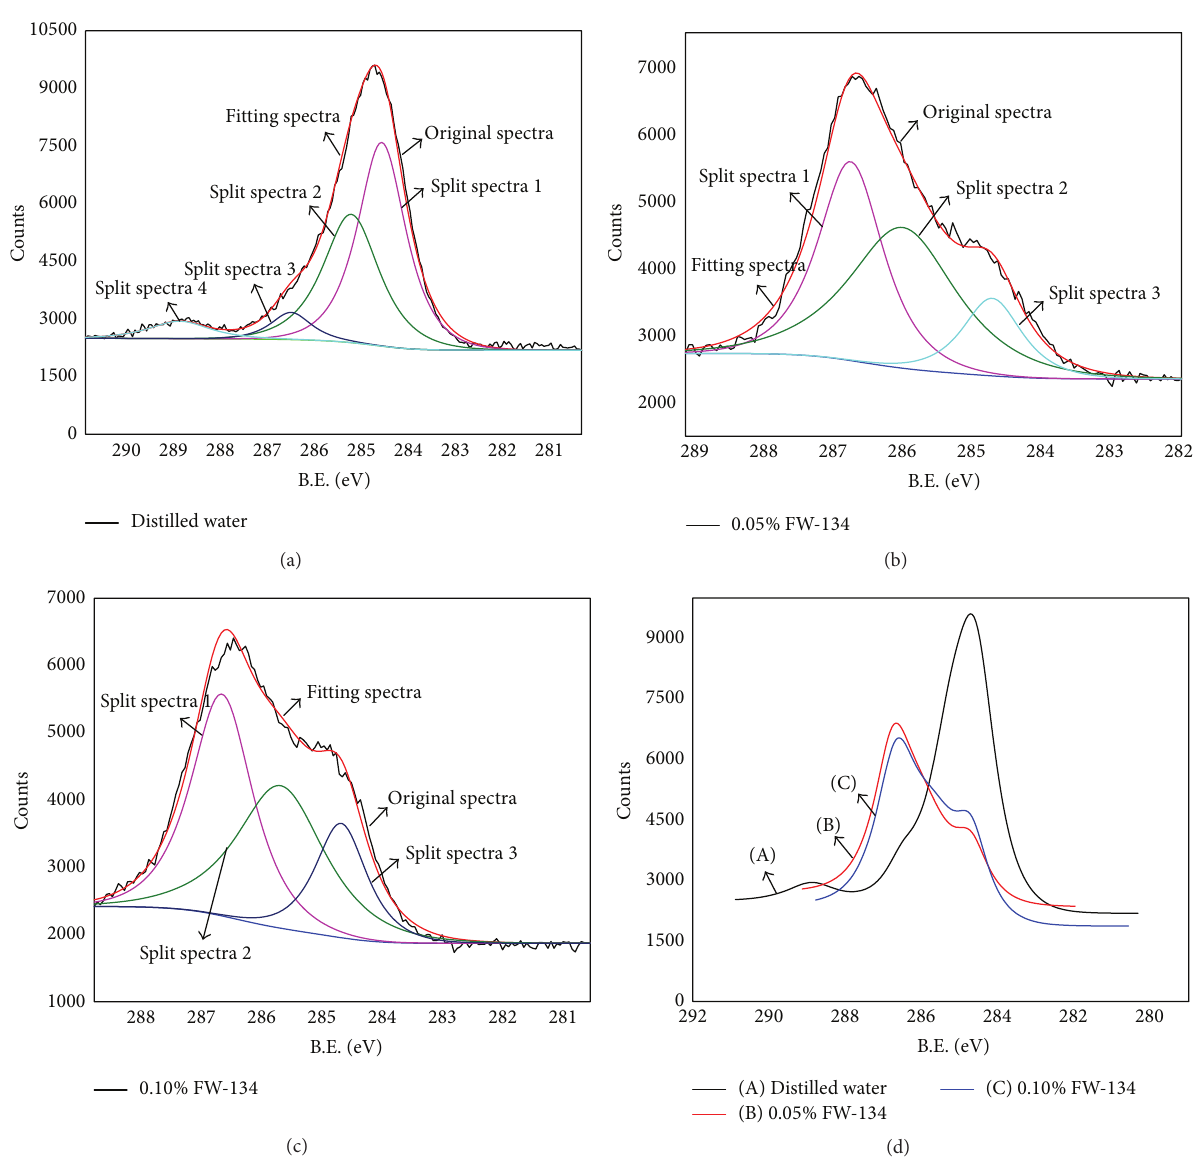
Figure 5: XPS C1s spectra of samples adsorbing FW-134 and contrast